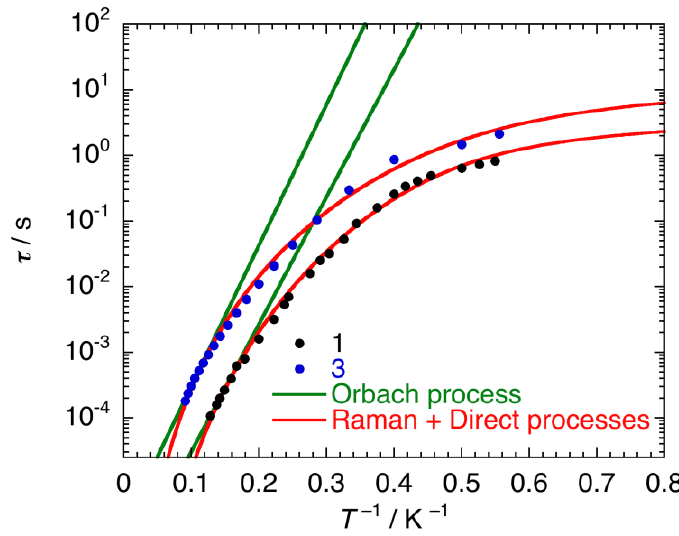
Figure 9. T -dependece of τ for 1 and 3 at 950 and 1500 Oe, respectively. Solid lines were fitted to the data as described in the text.